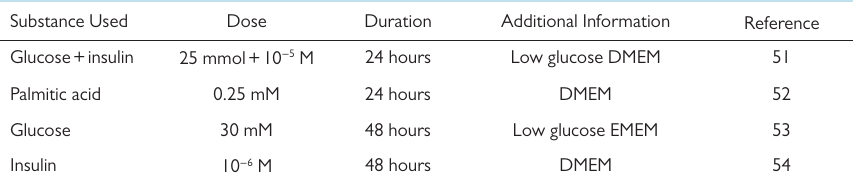
Table 3. Insulin Resistance Procedures in HepG2 Cell Lines Substance